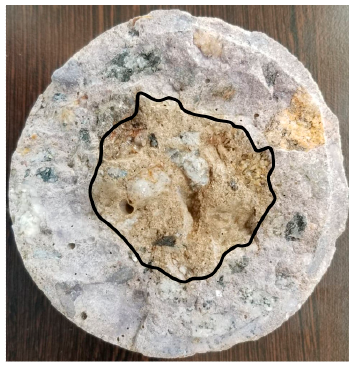
Figure 3. Application of the colorimetric method.